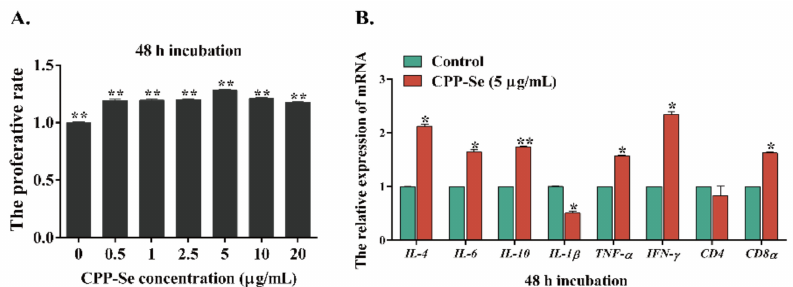
Figure 6. Changes in cell proliferation ( A ) and cytokine-related mRNAs expression ( B ) after PBL treated with 5 µ g/mL CPP-Se in vitro. “*” indicates statistical significance at p < 0.05, “**” indicates statistical significance at p <